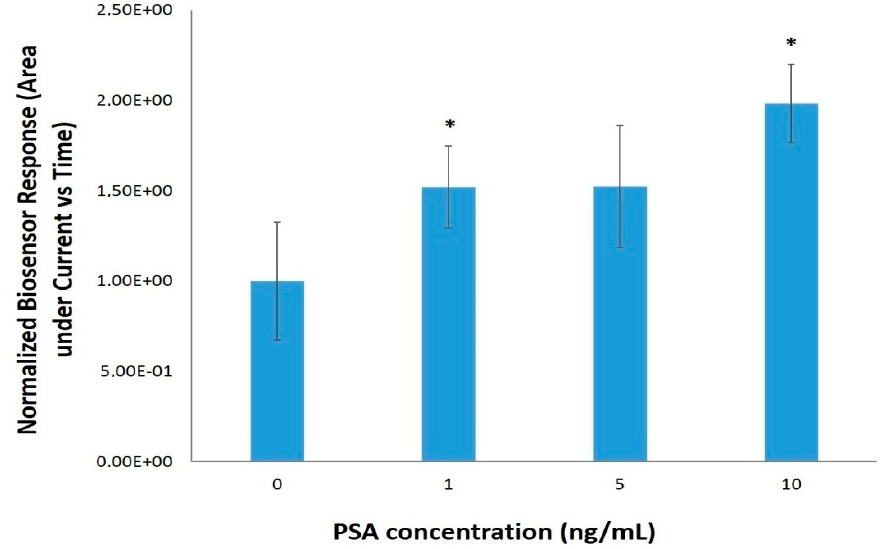
Figure 3. Linear calibration curve of chronoamperometric PSA detection. Plot of normalized immunosensor response of chronoamperograms (area under current vs. time) of HRP/Ab2/Ag/Ab1/BSA/AuNP-C in 0.01% H 2 O 2 and 0.015% TMB in acetate buffer at pH: 5.6 for various concentrations of PSA (1–10 ng/mL) at an applied potential of − 100 mV. * p < 0.05, significantly different from control.